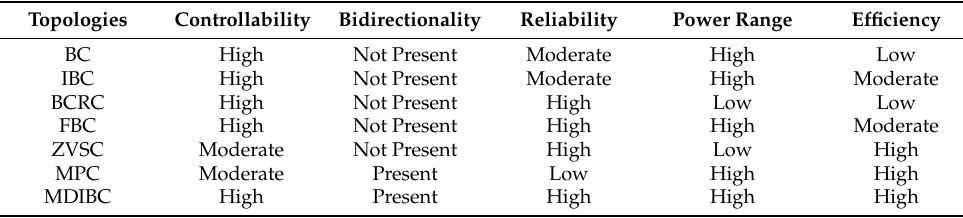
Table 10. Functionalities comparison of DC–DC converters